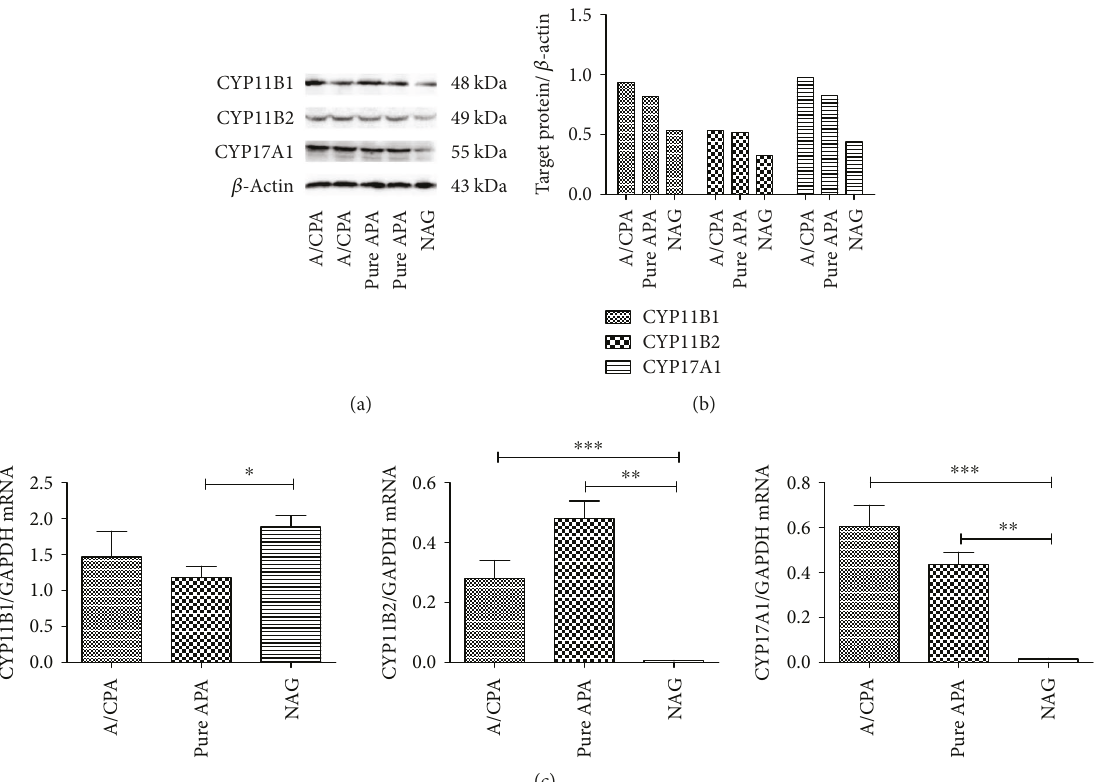
Figure 1: CYP11B1, CYP11B2, and CYP17A1 mRNA and protein expression levels in A/CPA tissue, pure APA tissue, and normal adrenal glands (NAGs). (a) Western blot showing CYP11B1, CYP11B2, and CYP17A1 protein bands in the A/CPA, pure APA, and NAG tissues. (b) The intensity of the CYP11B1, CYP11B2, and CYP17A1 protein bands compared with β -actin. (c) CYP11B1, CYP11B2, and CYP17A1 mRNA expressions in A/CPA, pure APA, and NAG tissues. ∗ P < 0 05 , ∗∗ P < 0 01 , ∗∗∗ P < 0 001